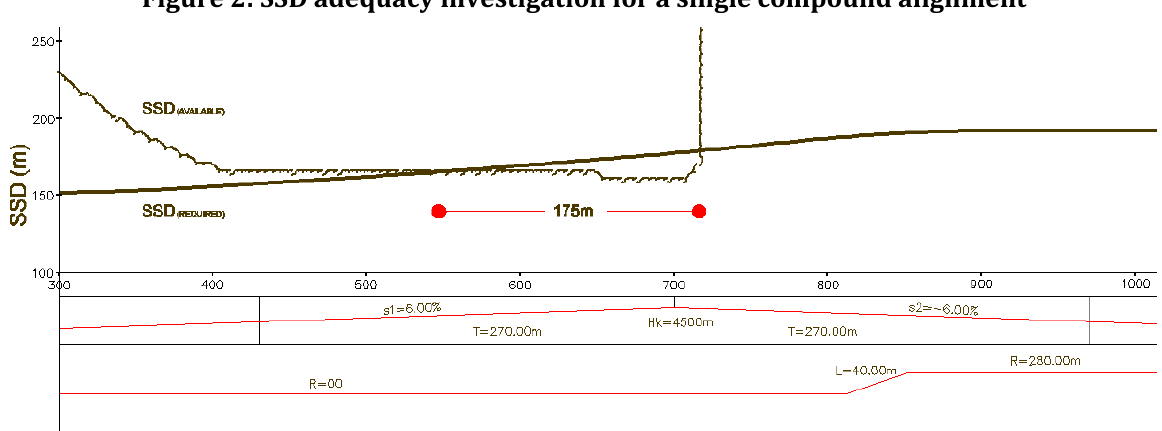
Figure 2: SSD adequacy investigation for a single compound alignment